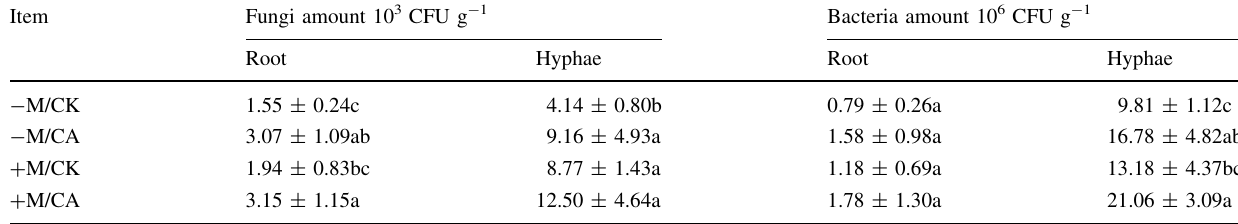
Table 2 The amount of soil fungi and bacteria Item